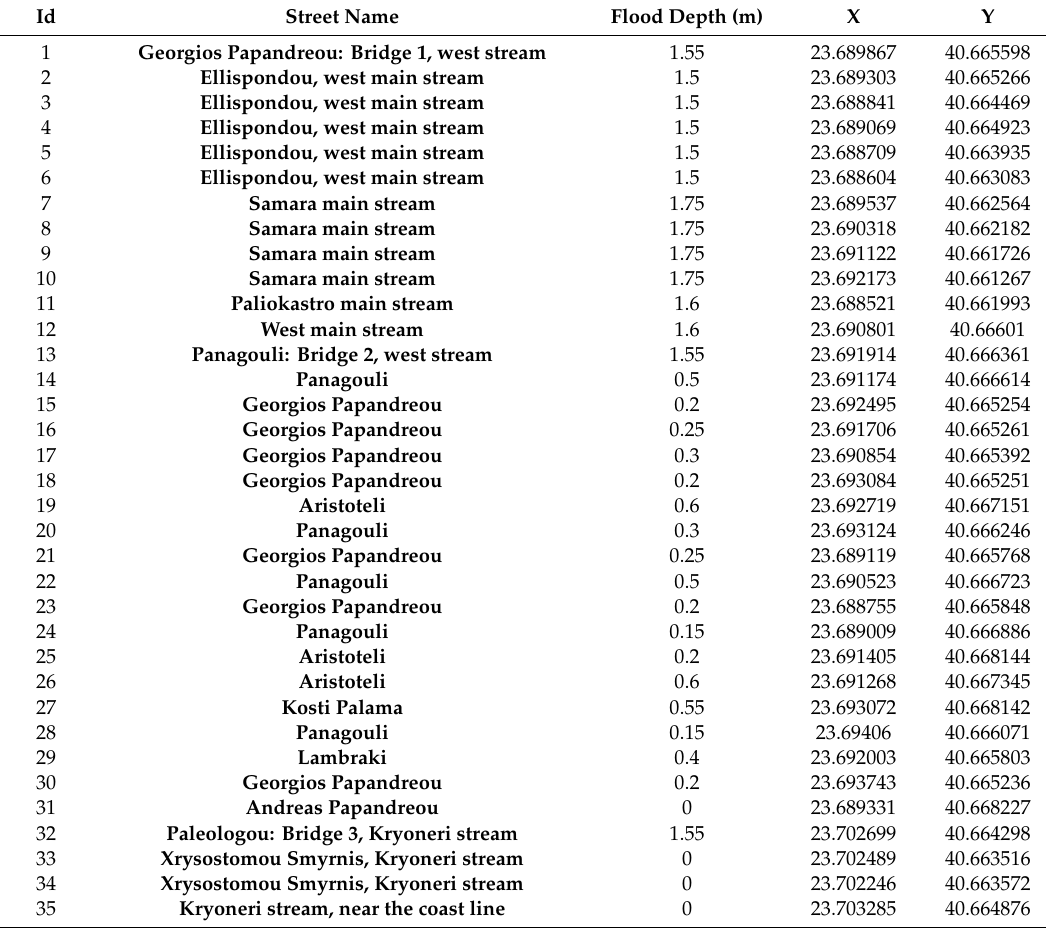
Table 7. Flood depth points at the Stavros floodplain after the flood on June